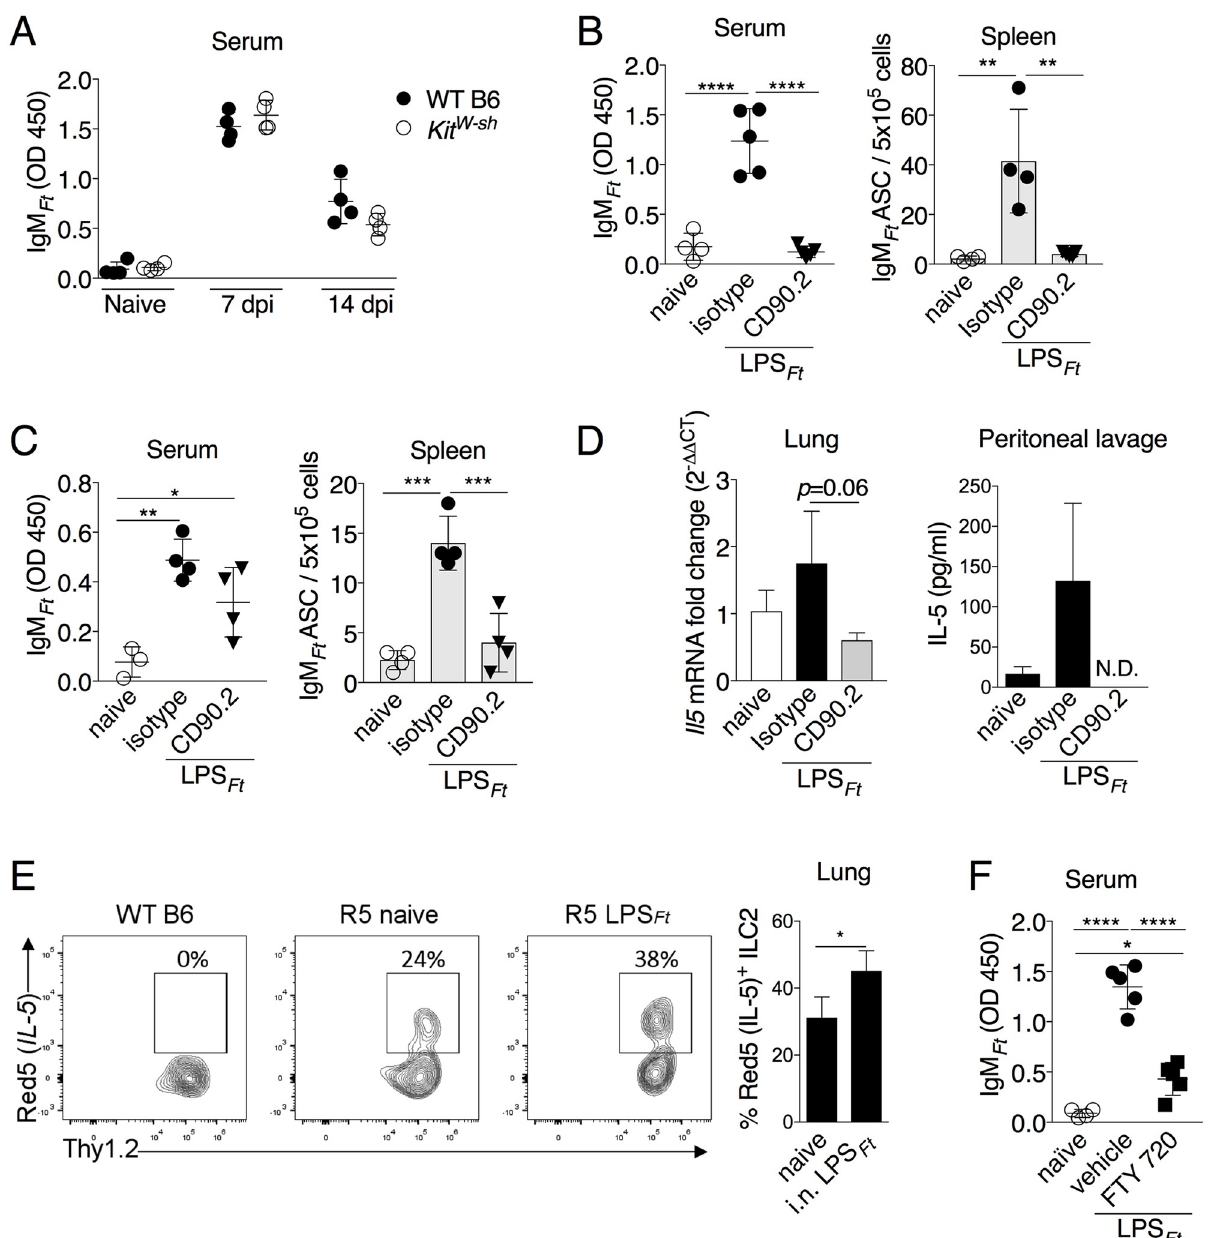
Fig 4. ILC2 are the source of IL-5 and are critical for IgM production by B1 cells. (A) Level of IgM in serum of i.p. LPS -immunized WT B6 or Ft . Ft Ft mast cells-deficient Kit W-sh mice on day 7 p.i. (B) Rag1 -/- mice reconstituted with WT peritoneal B cells or WT B6 mice (C) were depleted of ILC2 by i.p. injection of anti-CD90.2 or isotype Ab and immunized i.n. with LPS . Level of IgM in serum and IgM ASC in spleen were measured on day 7 p.i. Ft Ft Ft (D) Il5 mRNA in lung and IL-5 protein in peritoneal wash were measured in WT B6 mice (n = 3) 18 hrs post-immunization (i.n.) with LPS Ft . (E) Red5 ( Il5 -/- ) mice (n = 3) were immunized with LPS i.n. and expression of the reporter tdTomato was examined by FACS 18 hrs later in the KLRG1 + ILC2. Ft (See S4 Fig). (F) WT B6 mice were treated with FTY720 and immunized with LPS Ft . IgM Ft in serum was measured on day 7 p.i. One representative experiment of two or three (F) is shown. Data are expressed as mean ± SD. A-D, Mann-Whitney U test; E, unpaired students t test; F one-way ANOVA Tukey Post-test. � p < 0.05, �� p < 0.01, ��� p < 0.001, ���� p < 0.0001. See also S4 Fig.